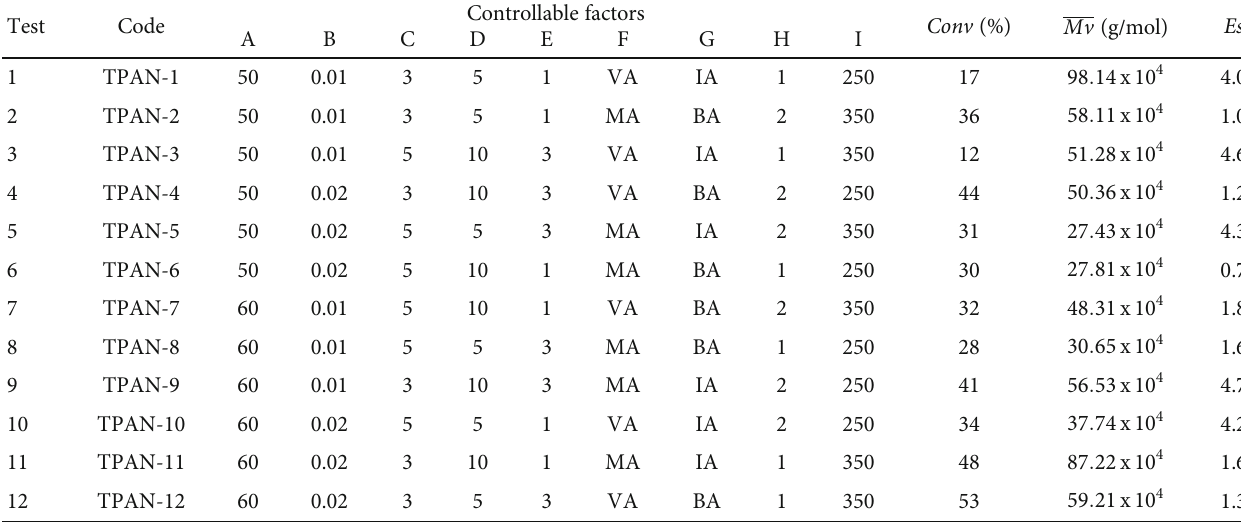
Table 4: Layout and results of L12 experimental design of the terpolymerization systems.